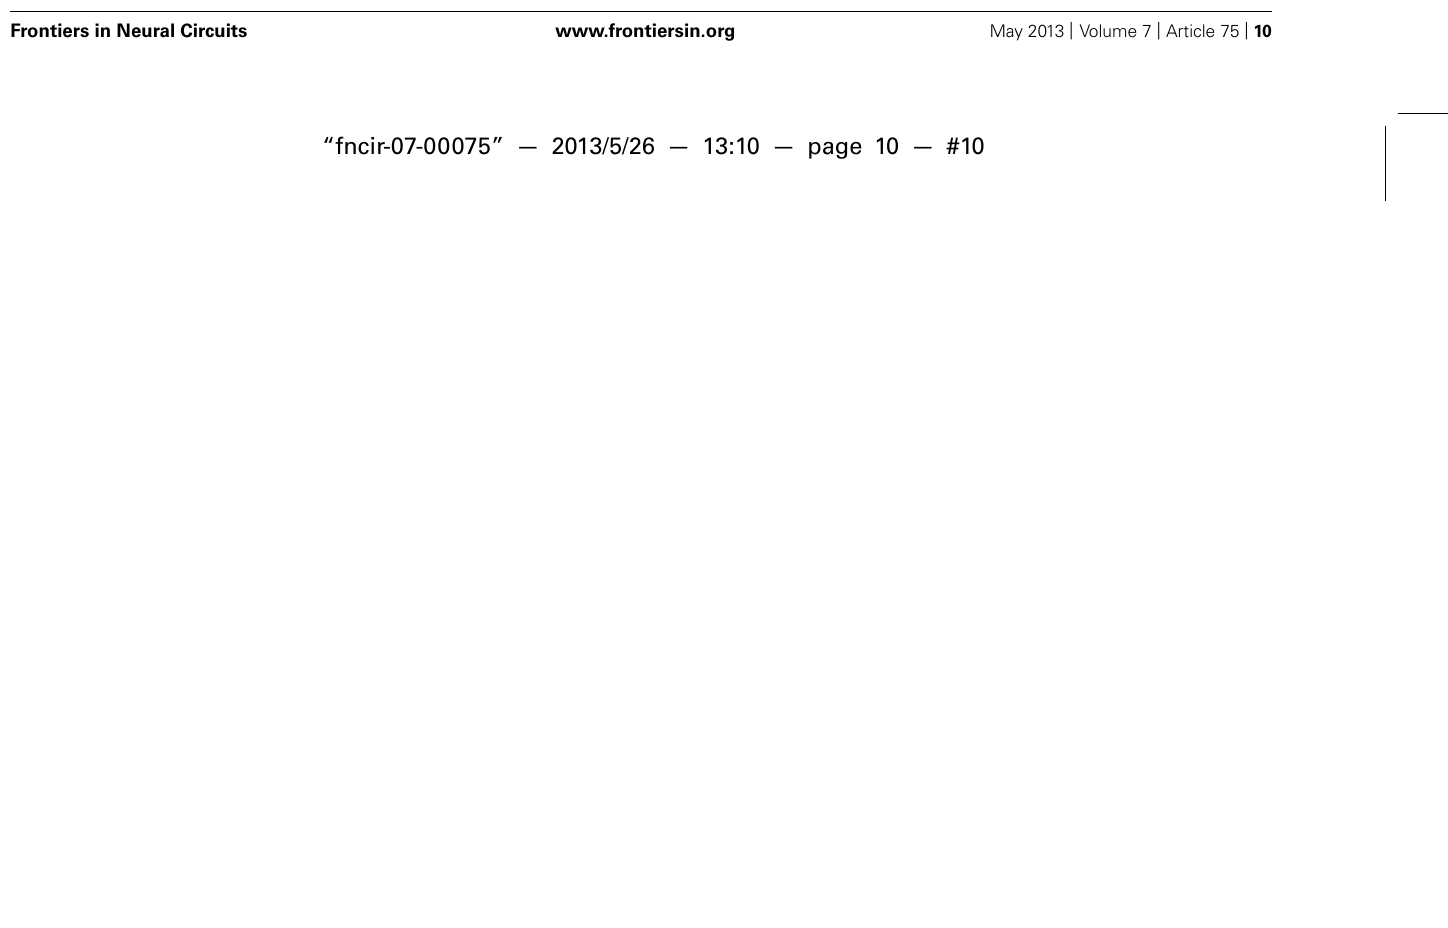
spiny neurons, 327 ± 164 (6%); and L2/3 pyramidal neurons, 167 ± 115 (3%). The L2/3-to-CTN connection was thus weak- est of the local excitatory connections to CTNs, being consistent with the previous results in motor-associated areas (Kaneko et